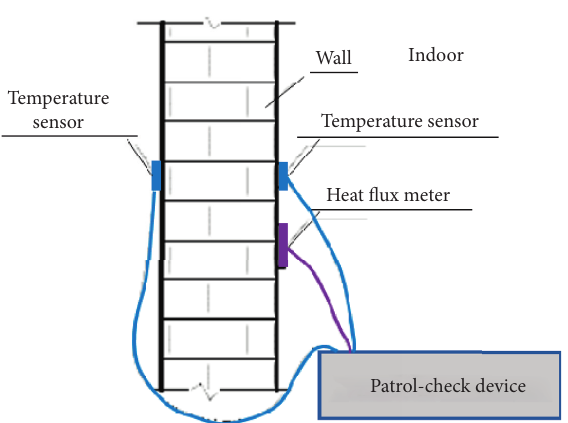
Figure 6: Heat flow meter